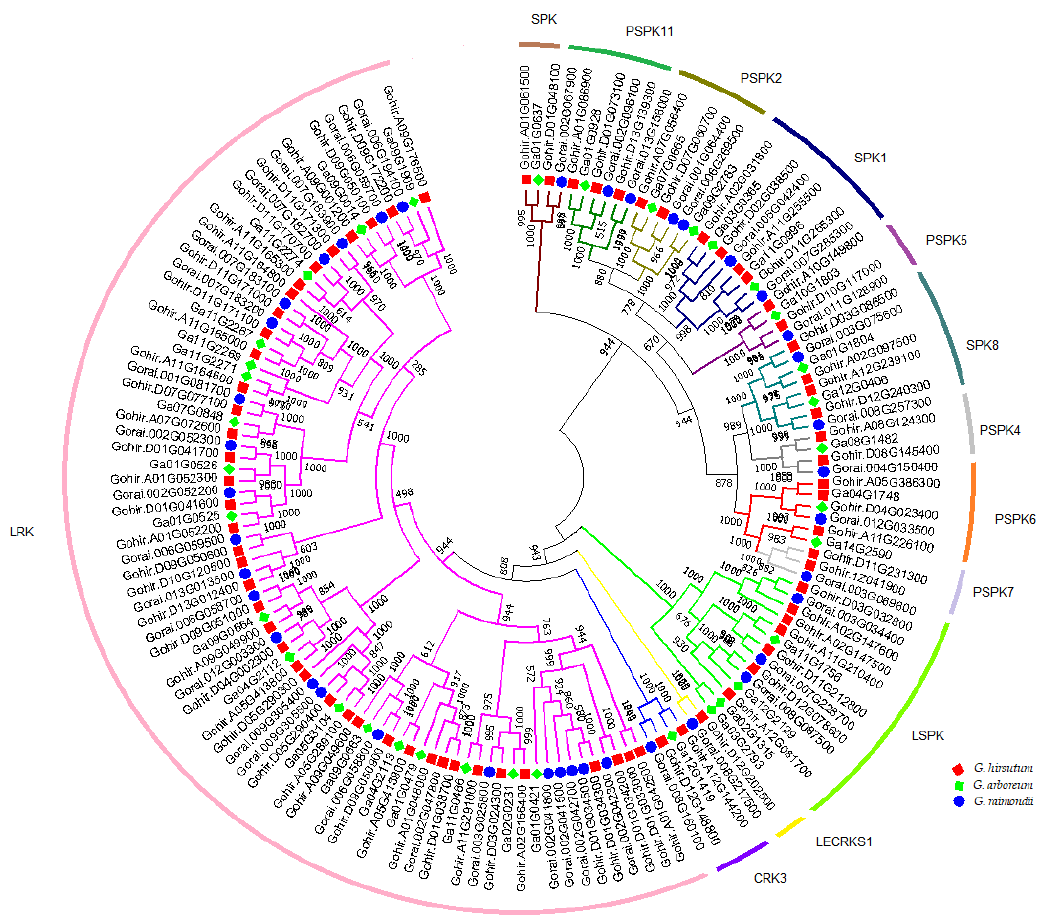
Figure 3. Phylogenetic tree relationship of 13 subfamilies of Pkinase genes in G. hirsutum , G. arboreum and G. raimondii constructed by MEGA 6.06. Different color border lines depict different gene subfamilies.